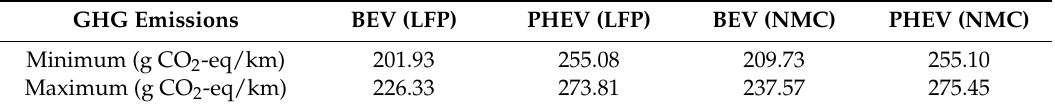
Table 11. The calculated range of life cycle GHG emissions for each